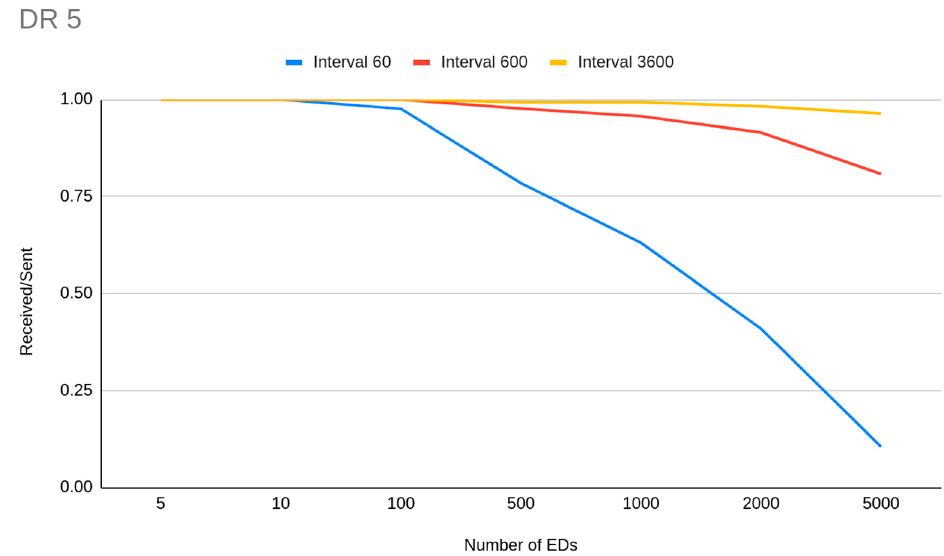
Figure 7. DR5 capacity related to transmission interval.